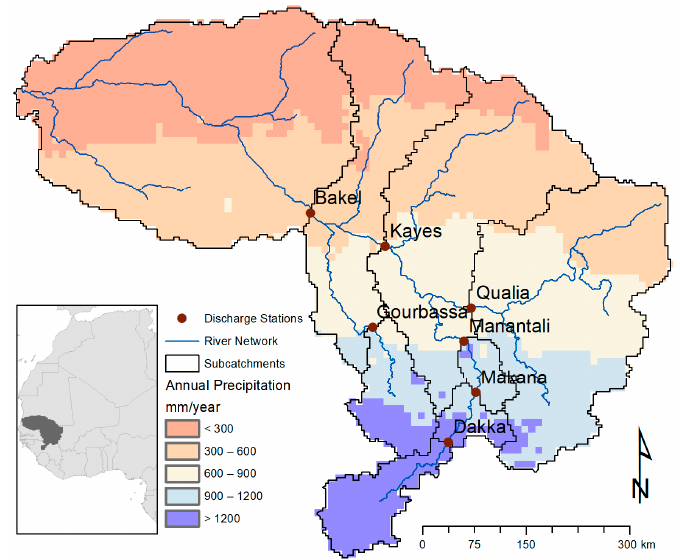
Figure 1. The Senegal River basin delineated as eight sub-catchments. The seven sub-catchments with available discharge records are stated by station names. The long-term average annual precipitation is based on CHIPRS 2.0 for the period of 1990–2019. The overview figure depicts the location of the Senegal River in Western Africa.